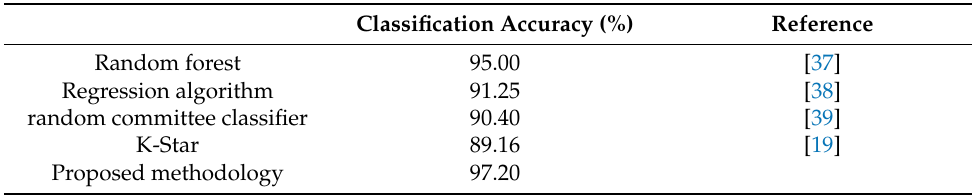
Table 4. Performance comparison using cutting-edge